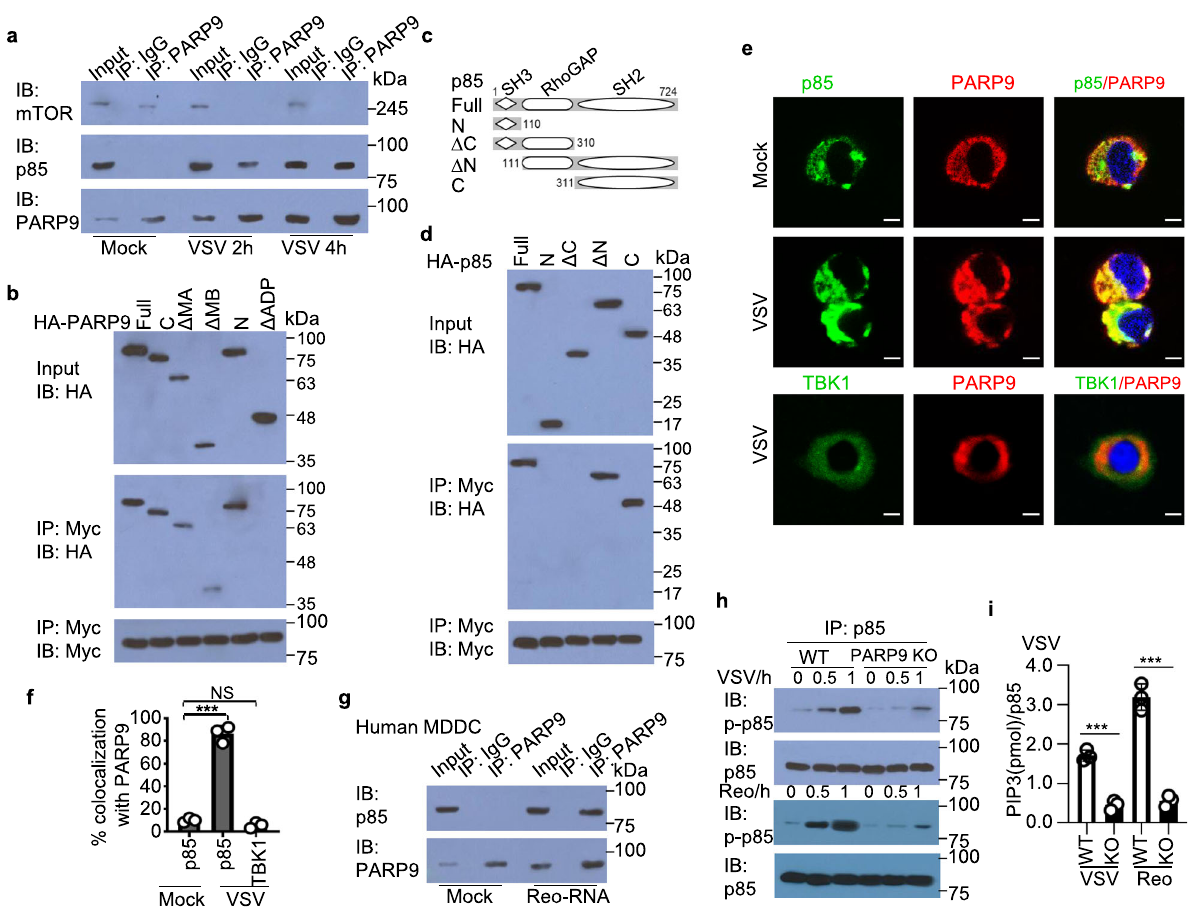
Fig. 6 PARP9 recruits and activates downstream PI3K p85. a Immunoblot analysis of endogenous proteins PARP9, mammalian target of rapamycin (mTOR) and phosphoinositide 3-kinase (PI3K) regulatory subunit p85 precipitated with anti-PARP9, or immunoglobulin G (IgG) from whole-cell lysates of wild-type BMDC left infected (Mock) or infected with VSV at MOI of 1 for 2 h or 4 h. b Immunoblot analysis of puri fi ed Myc-tagged p85 with anti-Myc antibody (bottom blot), and immunoblot analysis of puri fi ed HA-tagged full-length PARP9 and serial truncation of PARP9 with deletion ( Δ ) of various domains alone with anti-HA antibody (top blot) or after incubation with Myc-tagged p85 and immunoprecipitation with anti-Myc antibody (middle blot). c Schematic diagram showing full-length p85 (Full) and serial truncations of p85 with deletion ( Δ ) of various domain (left margin); numbers at ends indicate amino acid positions (top). SH3, the Src-homology 3 domain; RhoGAP, Rho GTPase activating protein domain; SH2, the Src-homology 2 domain. d Immunoblot analysis of puri fi ed Myc-tagged PARP9 with anti-Myc antibody (bottom blot), and immunoblot analysis of puri fi ed HA-tagged full-length p85 and serial truncations of p85 with deletion of various domains alone with anti-HA antibody (top blot) or after incubation with Myc-tagged PARP9 and immunoprecipitation with anti-Myc antibody (middle blot). e Confocal microscopy of primary peritoneal macrophages from WT mice left infected (Mock) or infected with VSV at MOI of 1 for 2 h. p85 or TBK1 was stained with mouse anti-PI3 kinase p85 alpha monoclonal antibody (Cat: ab86714, Abcam) or mouse anti-TBK1 monoclonal antibody (Cat: NB100-56705, Novus Biologicals), followed by Alexa Fluor 488 goat anti-mouse secondary antibody (green), while PARP9 was stained with rabbit anti-PARP9 polyclonal antibody (Cat: LS-B9440, LifeSpan BioSciences), followed by Alexa Fluor 594 goat anti-rabbit secondary antibody (red). DAPI (4 ′ ,6-diamidino-2-phenylindole) served as the nuclei marker (blue). Scale bars represent 10 µ m. f Quanti fi cation of colocalization between PARP9 and p85 or TBK1 using ImageJ software ( n = 3 per group). g Immunoblot analysis of endogenous proteins PARP9 and PI3K regulatory subunit p85 precipitated with anti-PARP9, or immunoglobulin G (IgG) from whole-cell lysates of human MDDC left transfected (Mock) or transfected with reovirus dsRNA (Reo-RNA) for 6 h. h Immunoblot analysis of endogenous proteins p85 and phosphorylated p85 (p-p85) precipitated with anti-p85 from whole-cell lysates of wild-type (WT) or PARP9 KO BMDC left infected (0 h) or infected with VSV or reovirus (Reo) at MOI of 1 for 0.5 or 1 h. i The relative amounts of PIP3 in the plasma membrane were normalized to the amount of immunoprecipitated p85 in WT and PARP9 KO BMDC after VSV infection ( n = 3 per group). Error bars indicate standard error of the mean for results in f , i . NS, not signi fi cant (p > 0.05), ***p < 0.001, and p value was calculated by unpaired two-tailed Student ’ s t test. Data are representative of three independent experiments. Exact p values ( f , p = 0.00007, p = 0.08; i , p = 0.0003, p = reduced after VSV or reovirus infection (Fig. 7a). However, expression of AKT3 was markedly induced in BMDC upon VSV or reovirus infection (Fig. 7a), indicating AKT3 maybe the downstream target of PI3K p85 activation. We next knocked down AKT1, AKT2, and AKT3 and examined the expression of IFN- β in BMDC followed by VSV or reovirus infection. We con fi rmed that the AKT1, AKT2, or AKT3 were ef fi ciently knocked down in VSV-infected BMDC (Fig. 7b). Knockdown of Indeed, PI3K p85 could interact with AKT3, but not AKT1 and